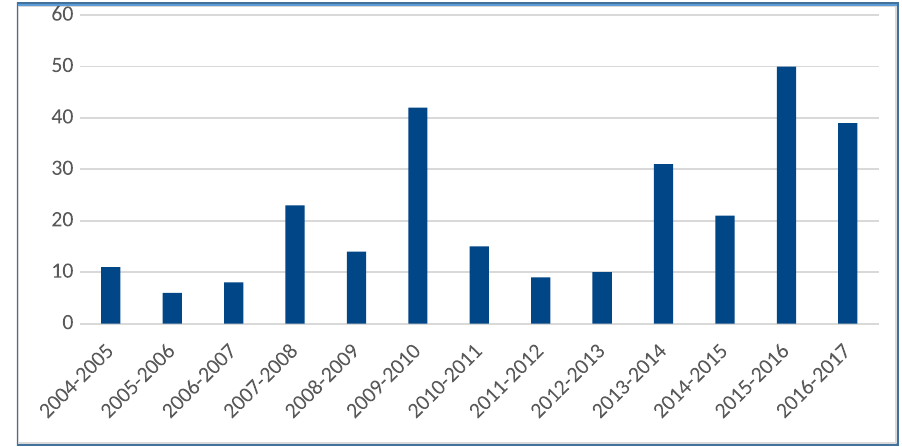
Figure 3. Total number of students that have taken the GIS academic course offered at the